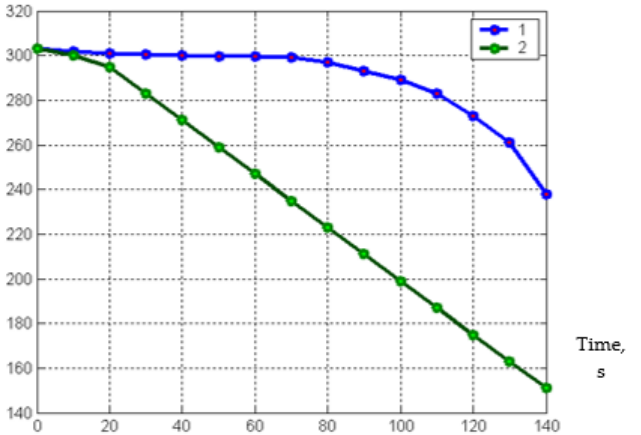
Figure 7. The temperature (K) dependence of freezing of squash pieces on time (s) with a freezing agent in nitrogen vapor and in liquid nitrogen; 1—freezing pieces of squash in nitrogen vapor, 2— freezing pieces of squash in liquid nitrogen.